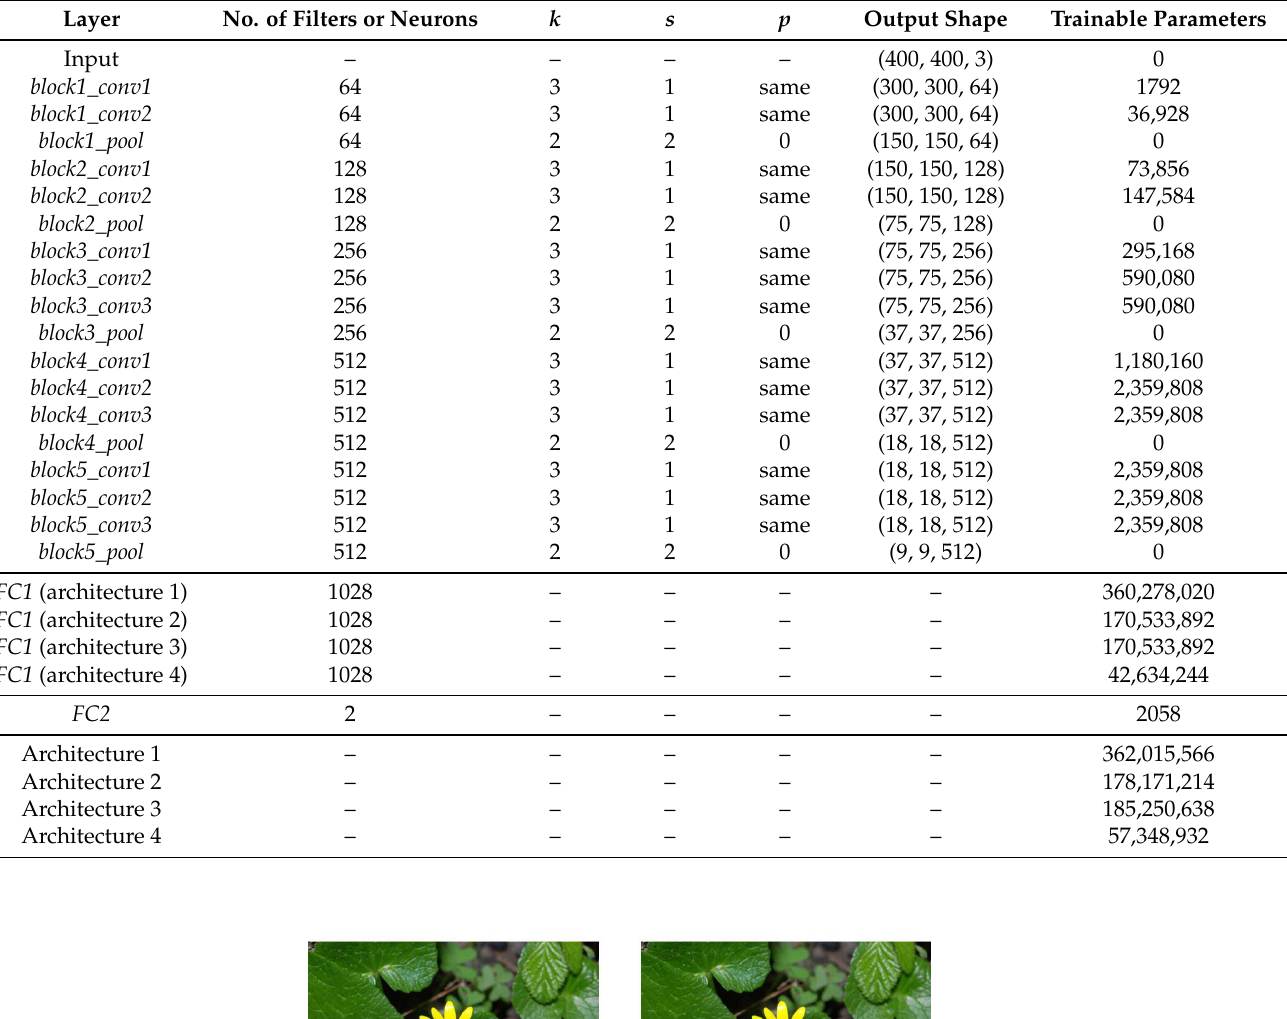
Table 2. Hyperparameters of the architectures by transfer learning: k is the kernel size, s is stride, p is padding. Layer No. of Filters or Neurons